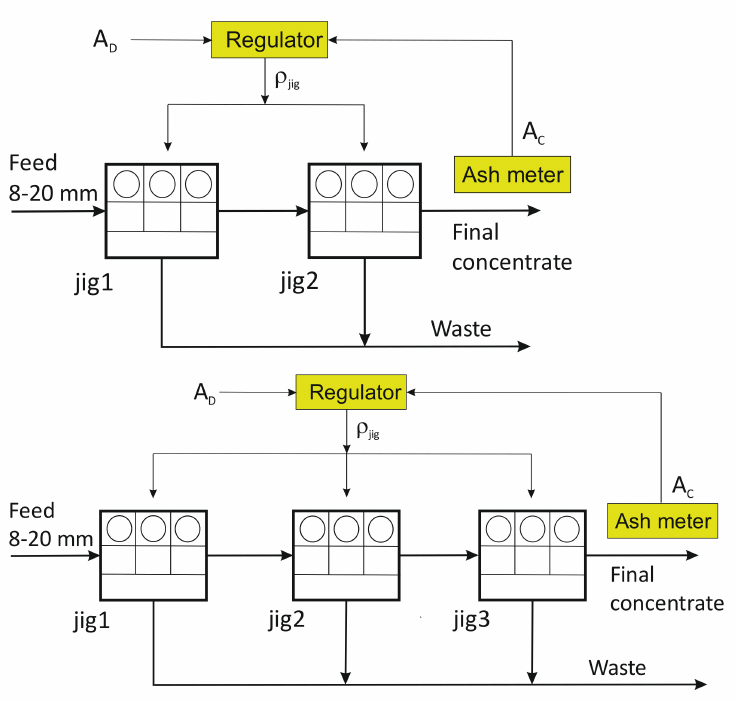
Figure 11. Maximum production value at different ash content in final concentrate in systems of jigs in the case of difficult-to-wash raw